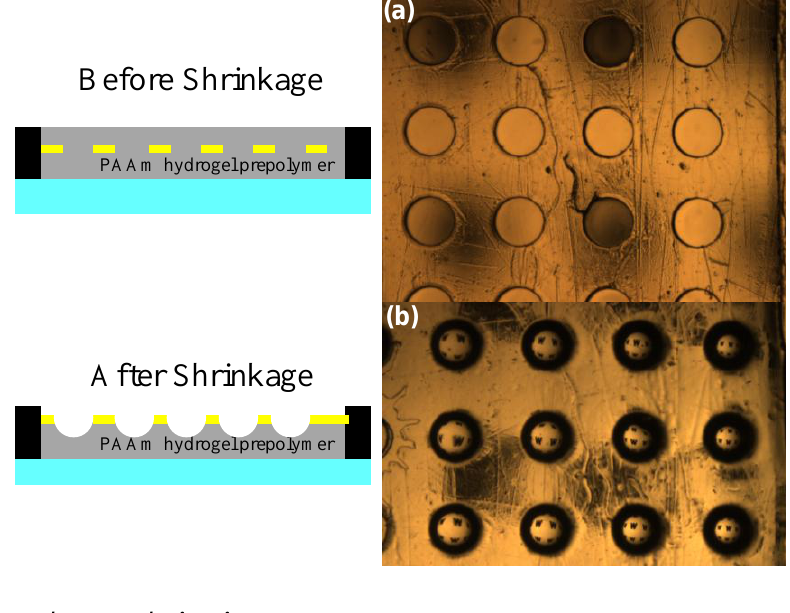
Figure 3. Images of the PAAm hydrogel on top of the poly-IBA. ( a ) Shows the PAAm right after exposure and before shrinking. ( b ) Shows clear images of “W” under the poly-IBA apertures. The images are erect, minified and are visible between the object plane and the aperture array, hence concave